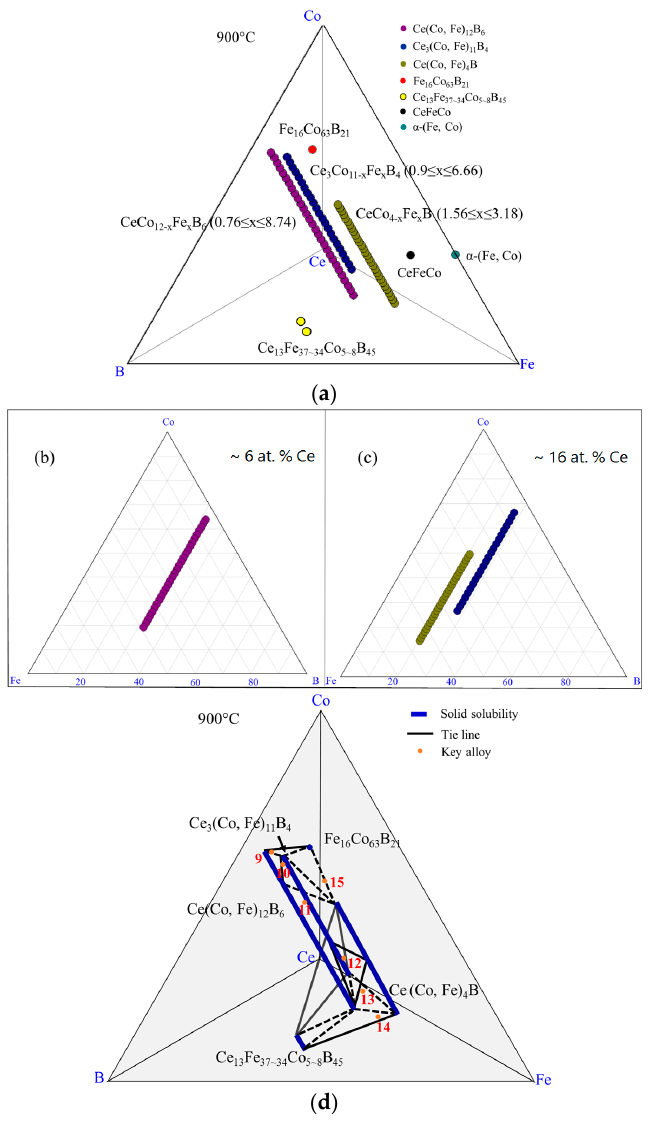
Figure 22. Homogeneity ranges of Ce 3 (Co, Fe) 11 B 4 and Ce(Co, Fe) 12 B 6 obtained from key alloys: ( a ) 3D presentation of the experimental results; ( b ) pseudo ternary section at ~6 at. % Ce; ( c ) pseudo ternary section at ~16 at. % Ce; ( d ) phase relations obtained from the key alloys. Combining the results which were obtained from the diffusion couples with those attained from the key alloys, the phases which were detected in the Ce-Fe-Co-B system in the Fe-Co rich region at 900 °C were plotted in Figure 23a. Seven three-phase equilibria were established as: α -(Fe, Co)/Ce 2 (Fe, Co) 14 B/Ce 2 (Fe, Co) 17 ; Ce 2 (Fe, Co) 14 B/Ce(Co, Fe) 4 B/CeFeCo; Ce 2 (Fe, Co) 17 /Ce(Co, Fe) 4 B/ α -(Fe, Co); Ce 3 (Co, Fe) 11 B 4 /Ce(Co, Fe) 12 B 6 /Ce(Co, Fe) 4 B; Ce 3 (Co, Fe) 11 B 4 /Ce(Co, Fe) 12 B 6 / α -(Fe, Co); Ce 3 (Co, Fe) 11 B 4 /Ce(Co, Fe) 4 B/Ce 13 Fe 34 Co 8 B 45 , and Ce 3 (Co, Fe) 11 B 4 /Ce(Co, Fe) 4 B/ α -(Fe, Co). The phase relations of the Ce-Fe-Co-B system in the Fe-rich corner at 900 °C were plotted, as shown in Figure 23f. Solid lines are the tie-lines determined in this study and dotted lines represent the possible phase relations. Among those detected phases, Ce 2 (Fe, Co) 14 B, Ce(Co, Fe) 4 B, and Ce 3 (Co, Fe) 11 B 4 were magnetic phases in this system, which was proven by the MFM study. Also, Ce(Co, Fe) 12 B 6 was identified as non-magnetic. The phases formed in the Fe-Co-Ce system are plotted in the triangle, as shown in Figure 23a. Three pseudo ternary sections at around 6 at. %, 12 at. % and 16 at.